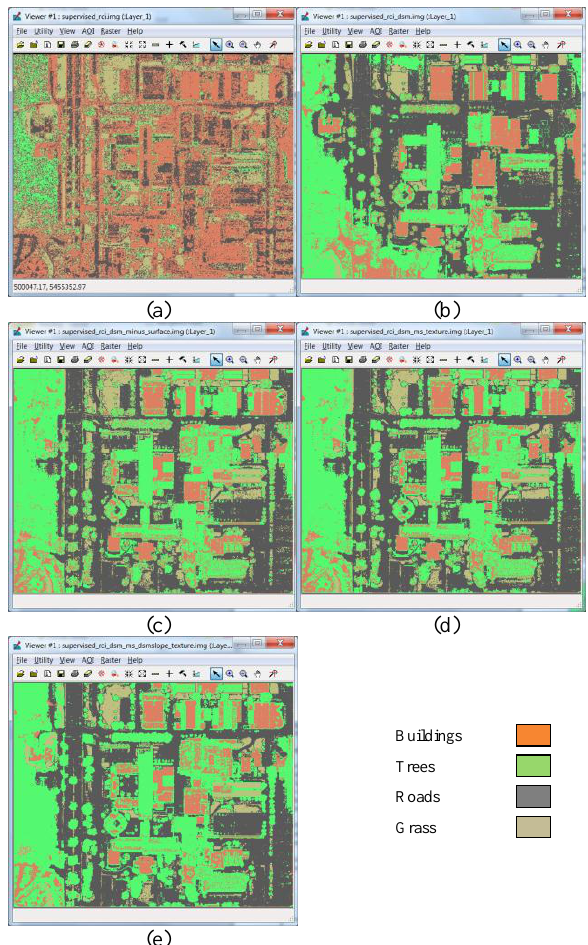
Figure 6: Results of Pixel-Based Classification